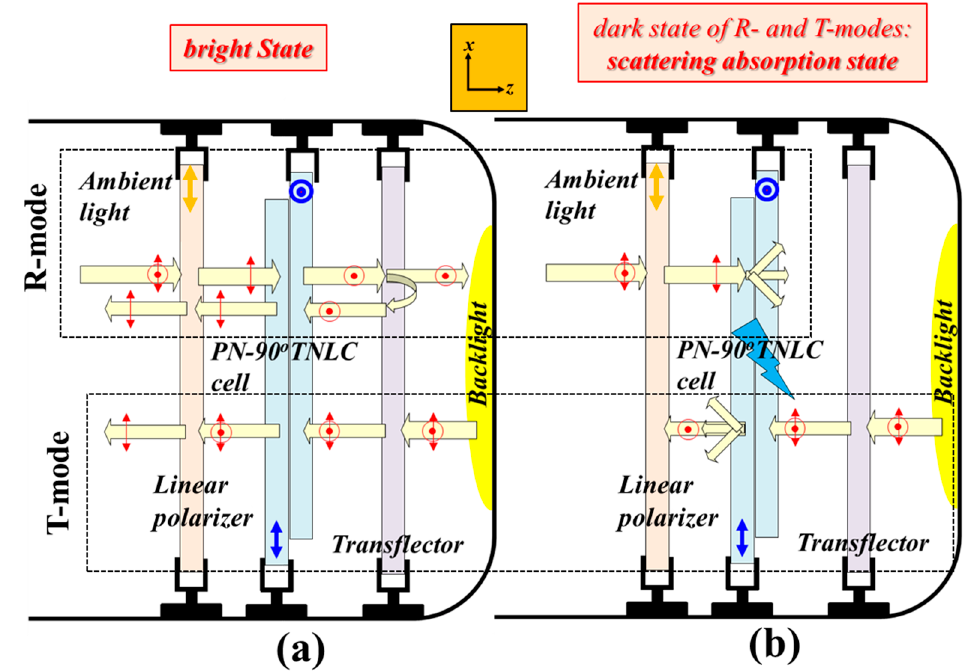
Figure 5. Configurations of a pixel of the ST-TRLCD#2 when the H-PNLC cell is replaced by a PN-90 ◦